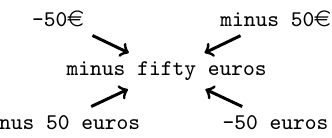
Figure 1. An example of equivalent phrases producing the same normalized